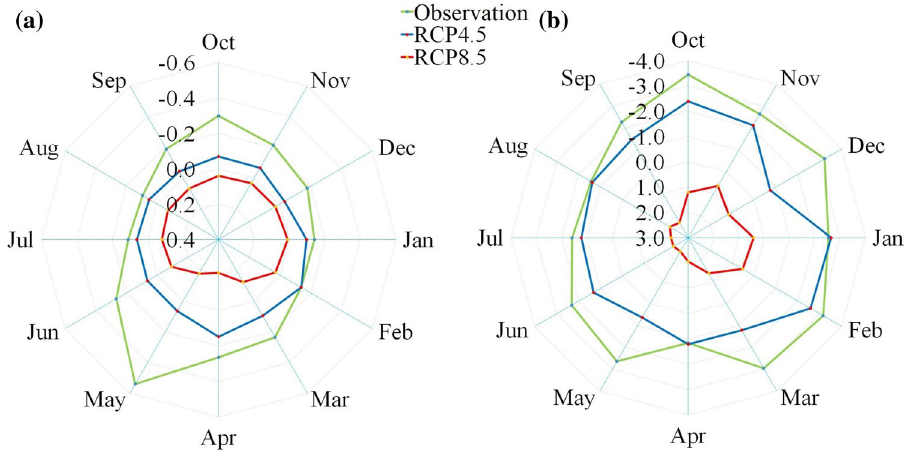
Fig. 9 The trend of streamflow: a Sen's slope b Z-MK in the future period with respect to two scenarios (RCP4.5 and